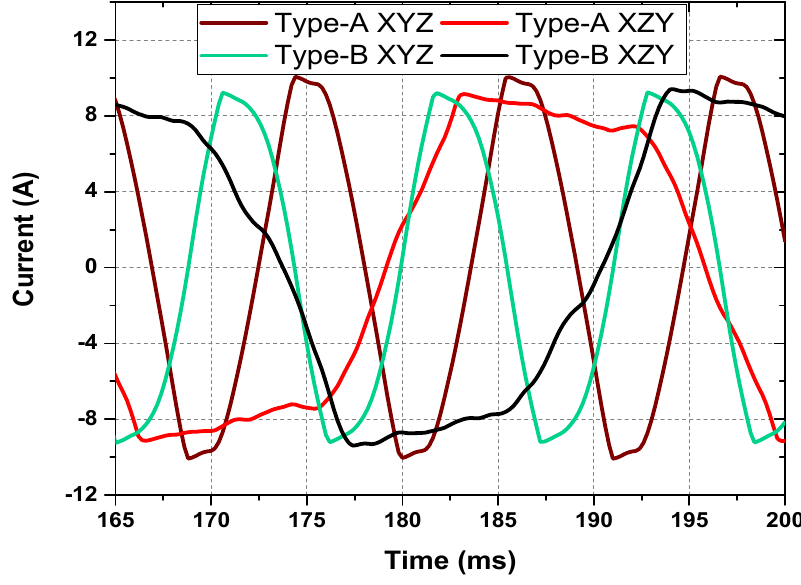
Figure 5. Harmonic currents comparison.